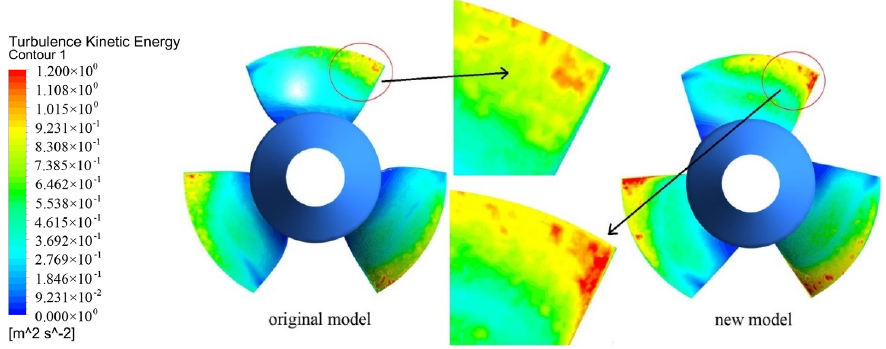
Figure 15. The rear blade’s turbulent kinetic energy distributions of original and new models.